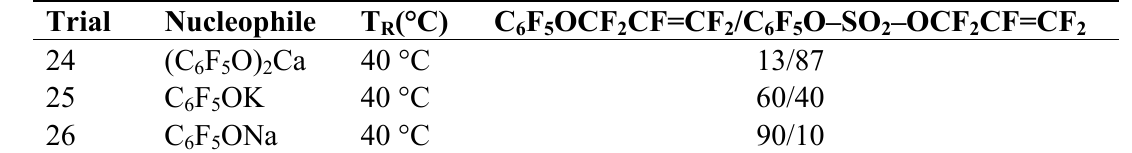
Table 6. Addition/Elimination vs. Substitution molar selectivities on FAFS as a function of the cation.